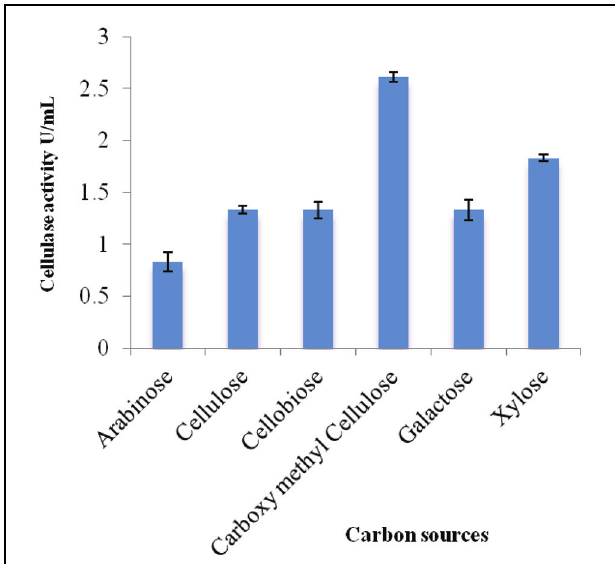
FIGURE 1 | Effect of carbon sources on cellulase activity of Enhydrobacter sp. ACCA2. The strain ACCA2 was cultured with a range of simple and complex carbon sources as sole carbon source and the cellulase activity was assayed in triplicates. The presented values are the mean and standard deviation.